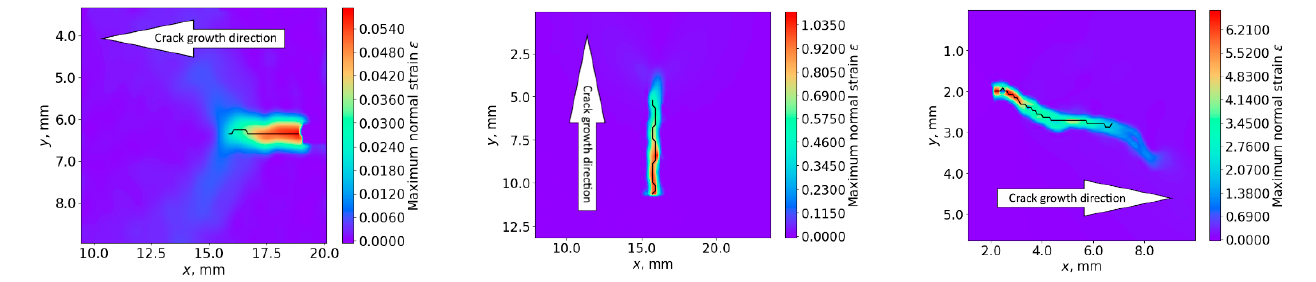
Figure 6 . Temporal dependencies of AE parameters in rail ( a ), wheelset ( b ), and traction clamp ( c )